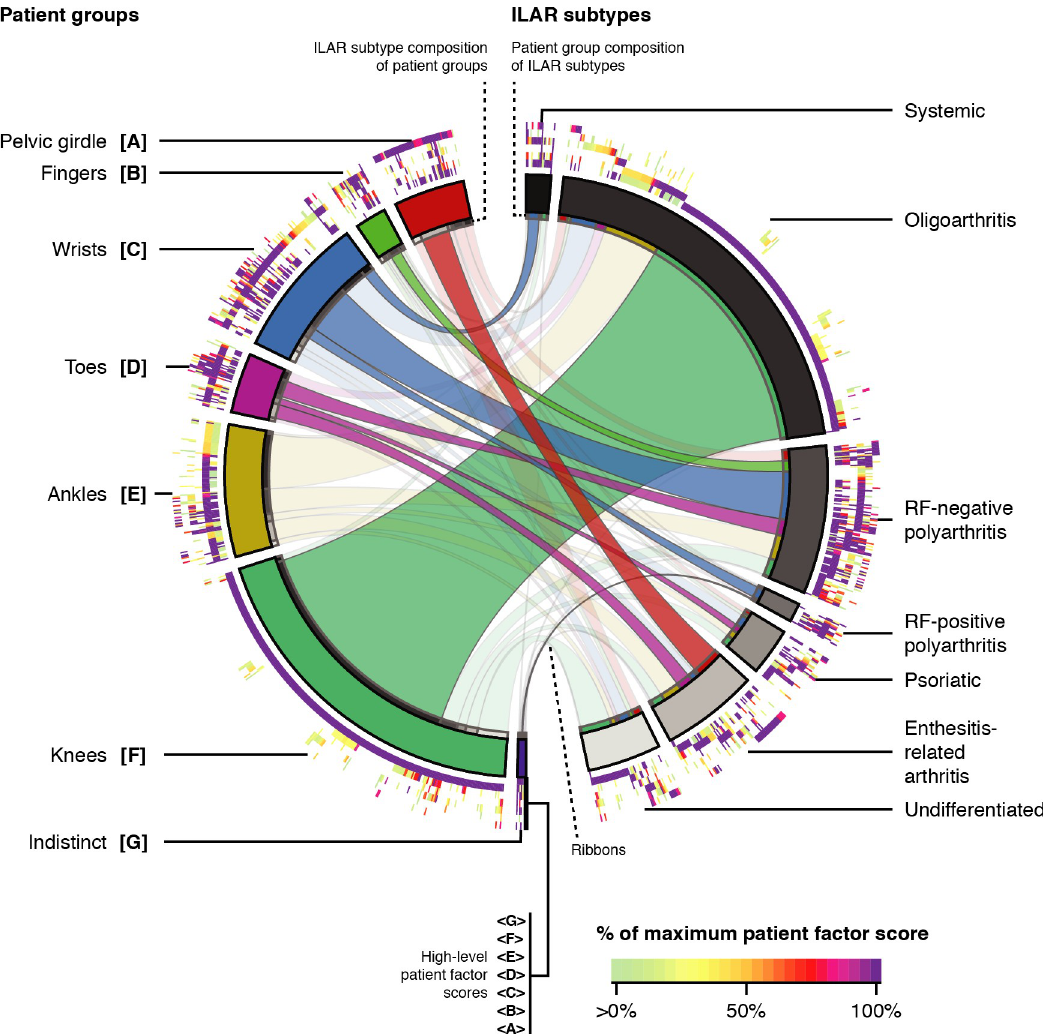
Fig 4. Patient groups subdivided ILAR subtypes. Circos figure visualizing relationships between patient groups (left; colored wedges in the second-innermost ring) and ILAR subtypes (right; grey wedges in the second-innermost ring). Heat maps (outer rings; bottom legend) display high-level patient factor scores, scaled to 0% to 100%, starting with < A pelvic girdle > moving outwards to factor < G sternoclavicular joints > . Each set of arcs along the radial axis, aligned along a ray from the center, represents an individual discovery cohort patient. Ribbons link groups of patients between patient groups and ILAR subtypes. Enriched relationships, as determined from a χ 2 test, appear more opaque. ILAR, International League of Associations for Rheumatology; RF, rheumatoid